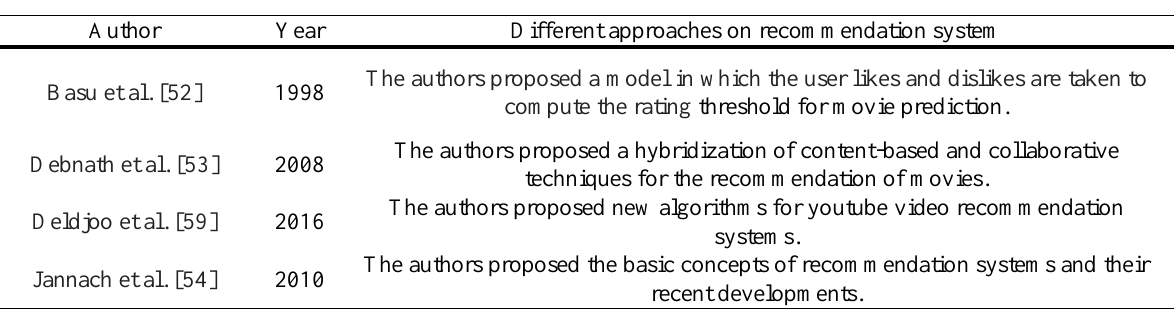
Table 2 discusses the different contributions in recommendation system. Table 2 . Literature review on recommendation system.